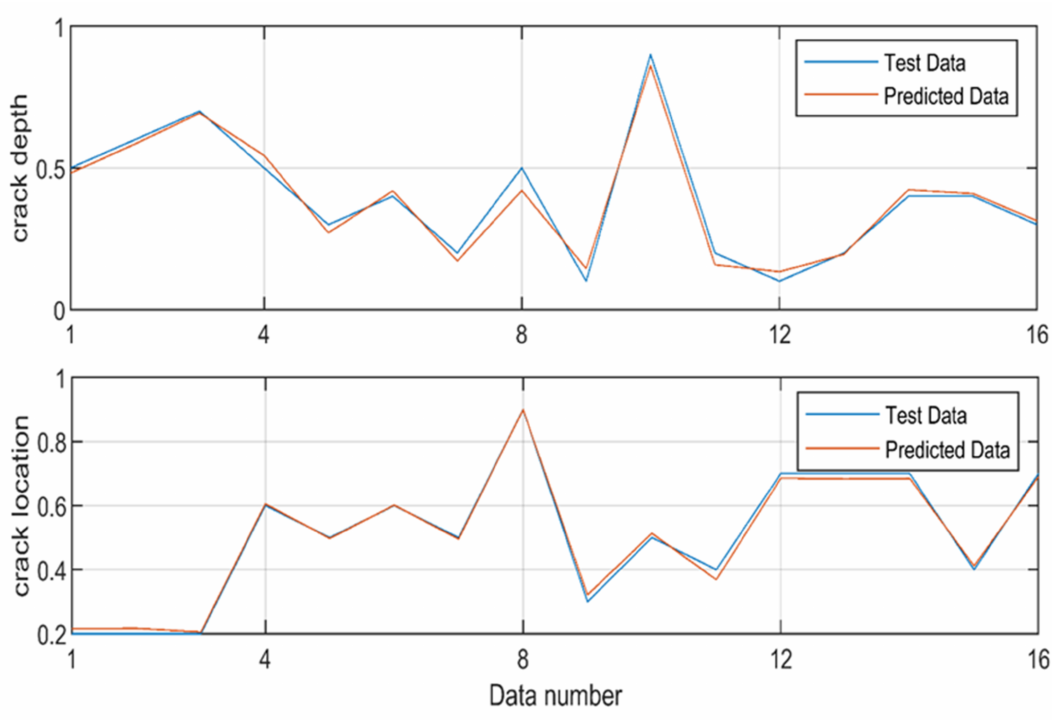
Figure 17. ANN testing and prediction results for both crack depths and